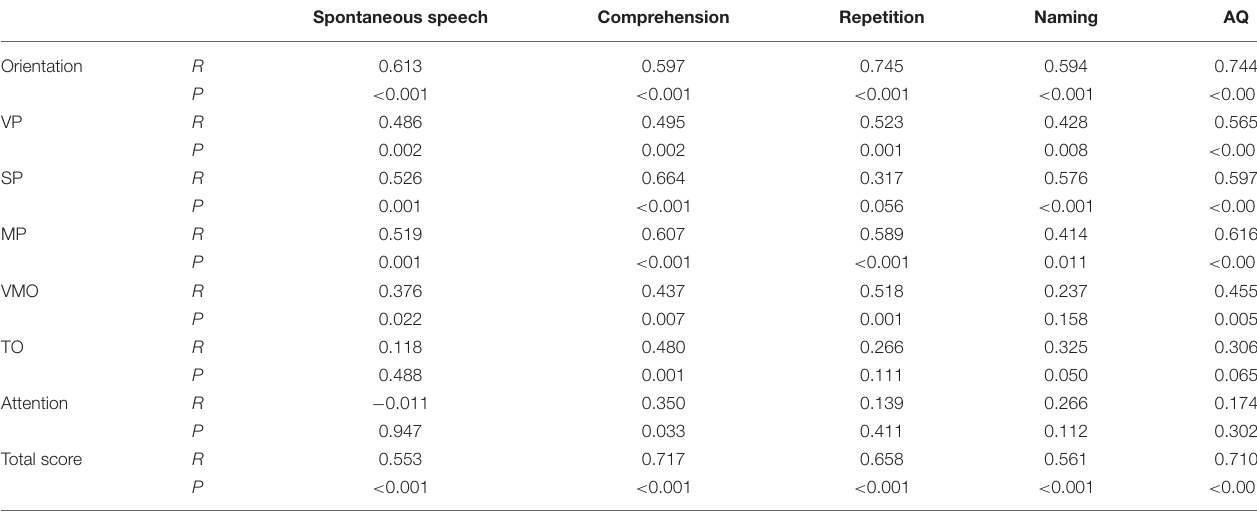
TABLE 6 | Partial correlation analysis between LOTCA scores and WAB scores of the PSA group. Spontaneous